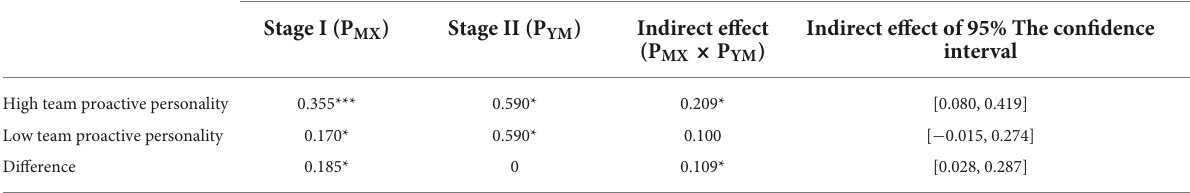
TABLE 5 Results of the moderated mediation